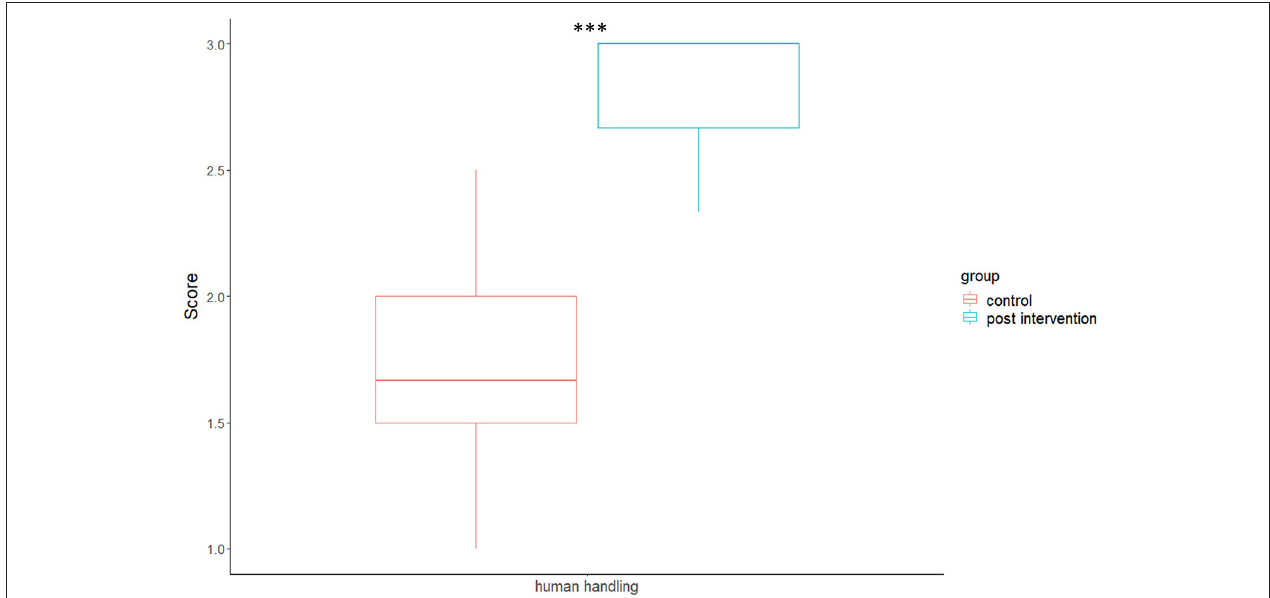
FIGURE 1 | Boxplots of humans’ handling scores for control and intervention conditions (* p < 0.05, ** p < 0.01, *** p < 0.001).